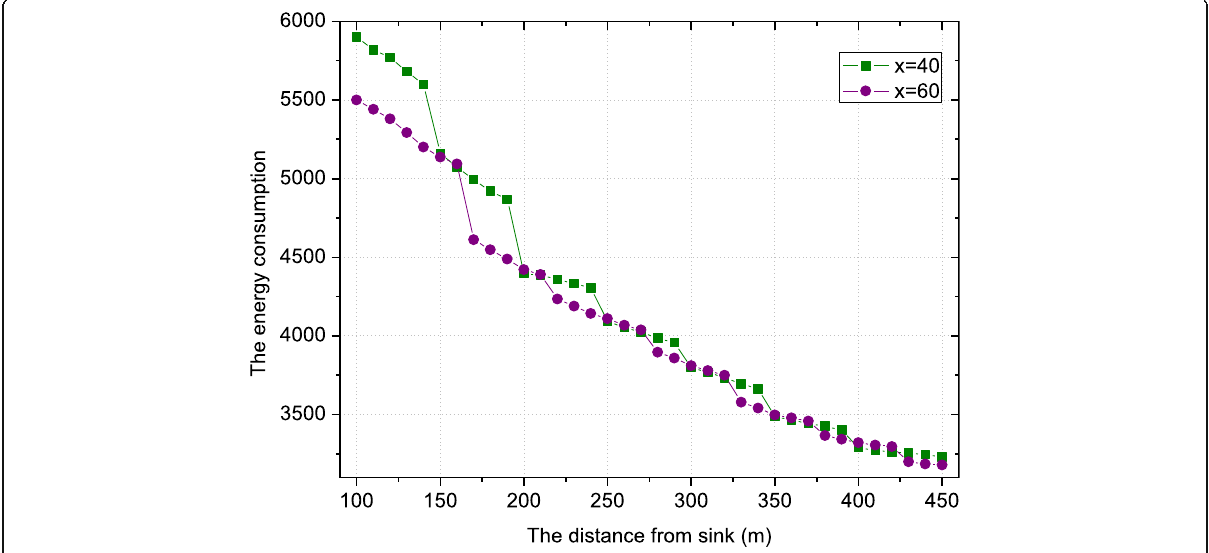
Fig. 10 The energy consumption under different x